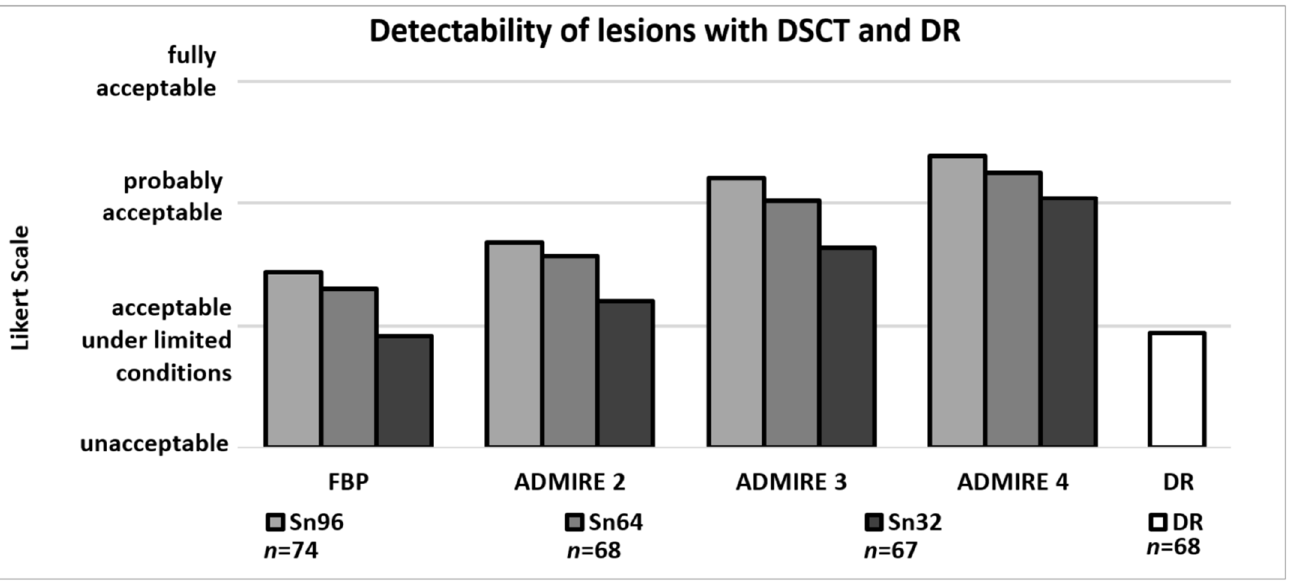
Figure 2. Detectability of suspicious lesions ( n ) with DSCT dependent on dose groups and iterative reconstruction set and DR. Detectability of lesions increases with rising levels of ADMIRE. With ADMIRE 4, detectability with DSCT was always acceptable (score of 3 or higher) and was significantly superior compared to DR.